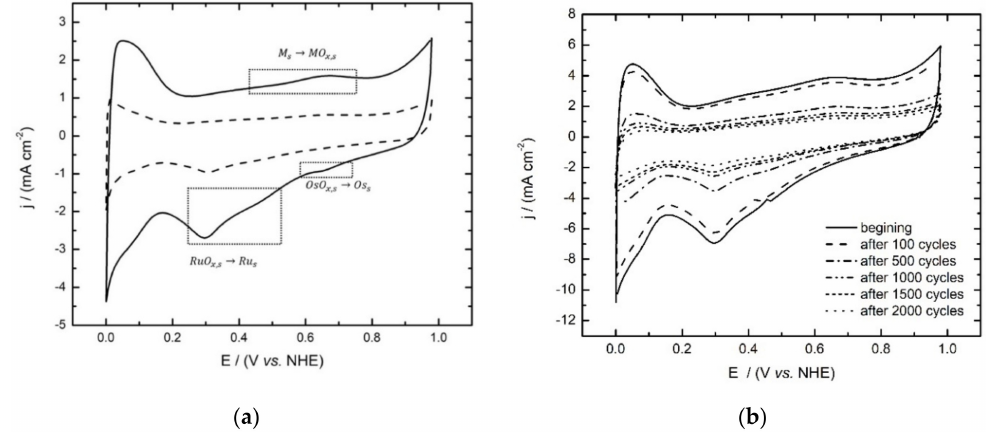
Figure 5. ( a ) Cyclic voltammograms of the OsRu electrocatalyst obtained for the HOR (---) and RRO ( — ) inks in 0.5 mol L − 1 H 2 SO 4 as the electrolyte at a sweep rate of 20 mV s − 1 and ( b ) successive voltammograms for stability proofs at 50 mV s 1 recorded at specific stages. Figure 5b represents the changes of voltammograms during ADT at different